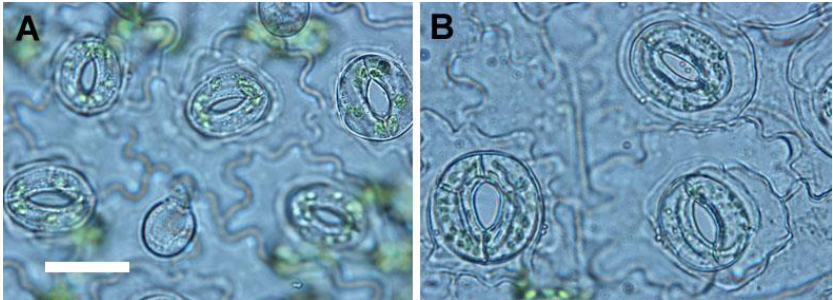
Figure 3. Growth and morphological responses of 2 x and 4 x plants of Salvia miltiorrhiza in vitro (bar = 2 cm for all figures). ( A ) 2 x plant. ( B ) 4 x plant.